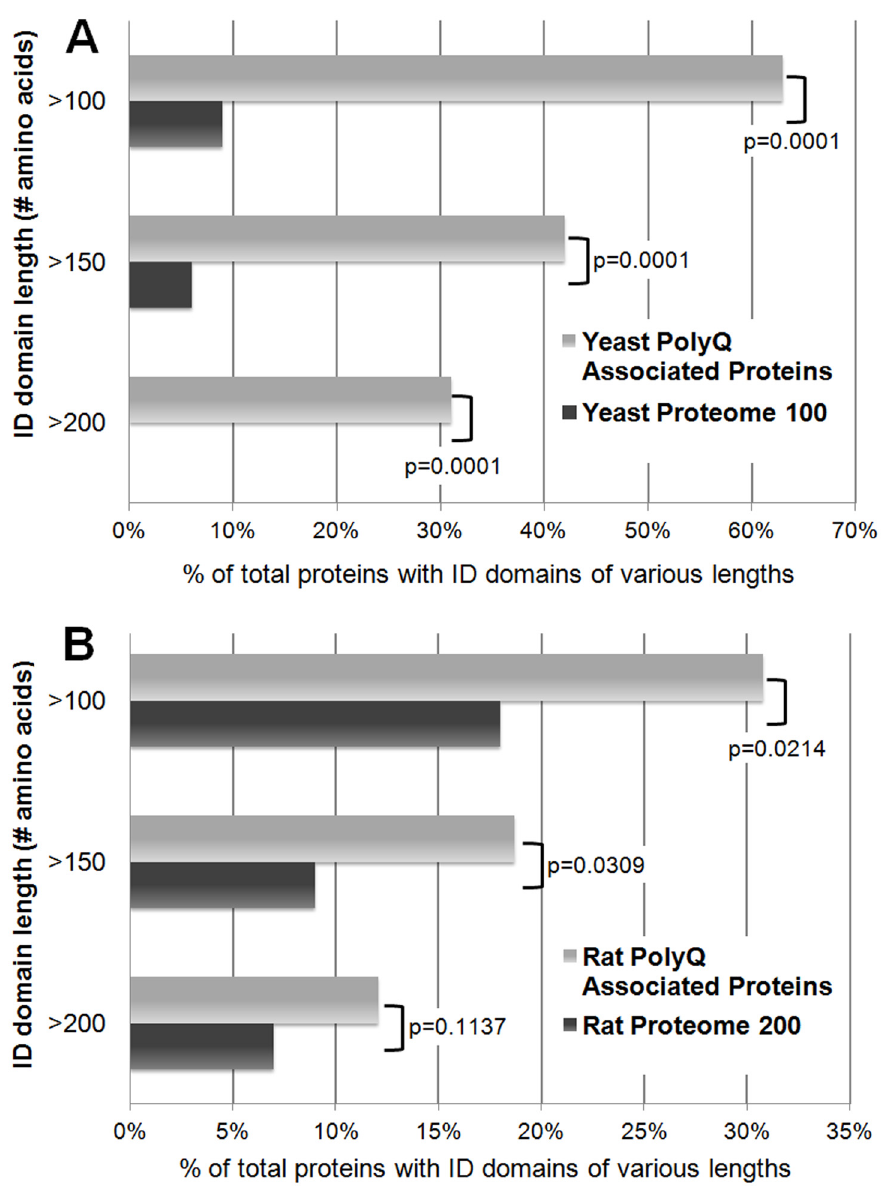
Fig 2. Cellular proteins trapped with Htt polyQ aggregates are disproportionately composed of long intrinsically-disordered (ID) domains. (A) Comparisons of the percentages of proteins with long ID domains of the 52 yeast proteins in Table 1 (reproducibly found by TAPI to be tightly associated with Htt- Q103-GFP aggregates) versus 100 randomly-selected yeast proteins (S1 File). Most of the identified proteins have long ID domains of at least 100 amino acids. (B) Comparisons of the percentages of proteins with long ID domains of the 91 rat proteins in Table 2 (reproducibly found by TAPI to be tightly associated with GFP-Htt- Q74 aggregates) versus 200 randomly-selected rat proteins (S2 File). ID domains are defined as regions of 30 or more amino acids with IUPred scores of 0.5 or greater [47, 98]. Chi-Square Fisher ’ s Exact test (Graphpad software) was used to determine significance between TAPI-identified proteins and proteome control sets.